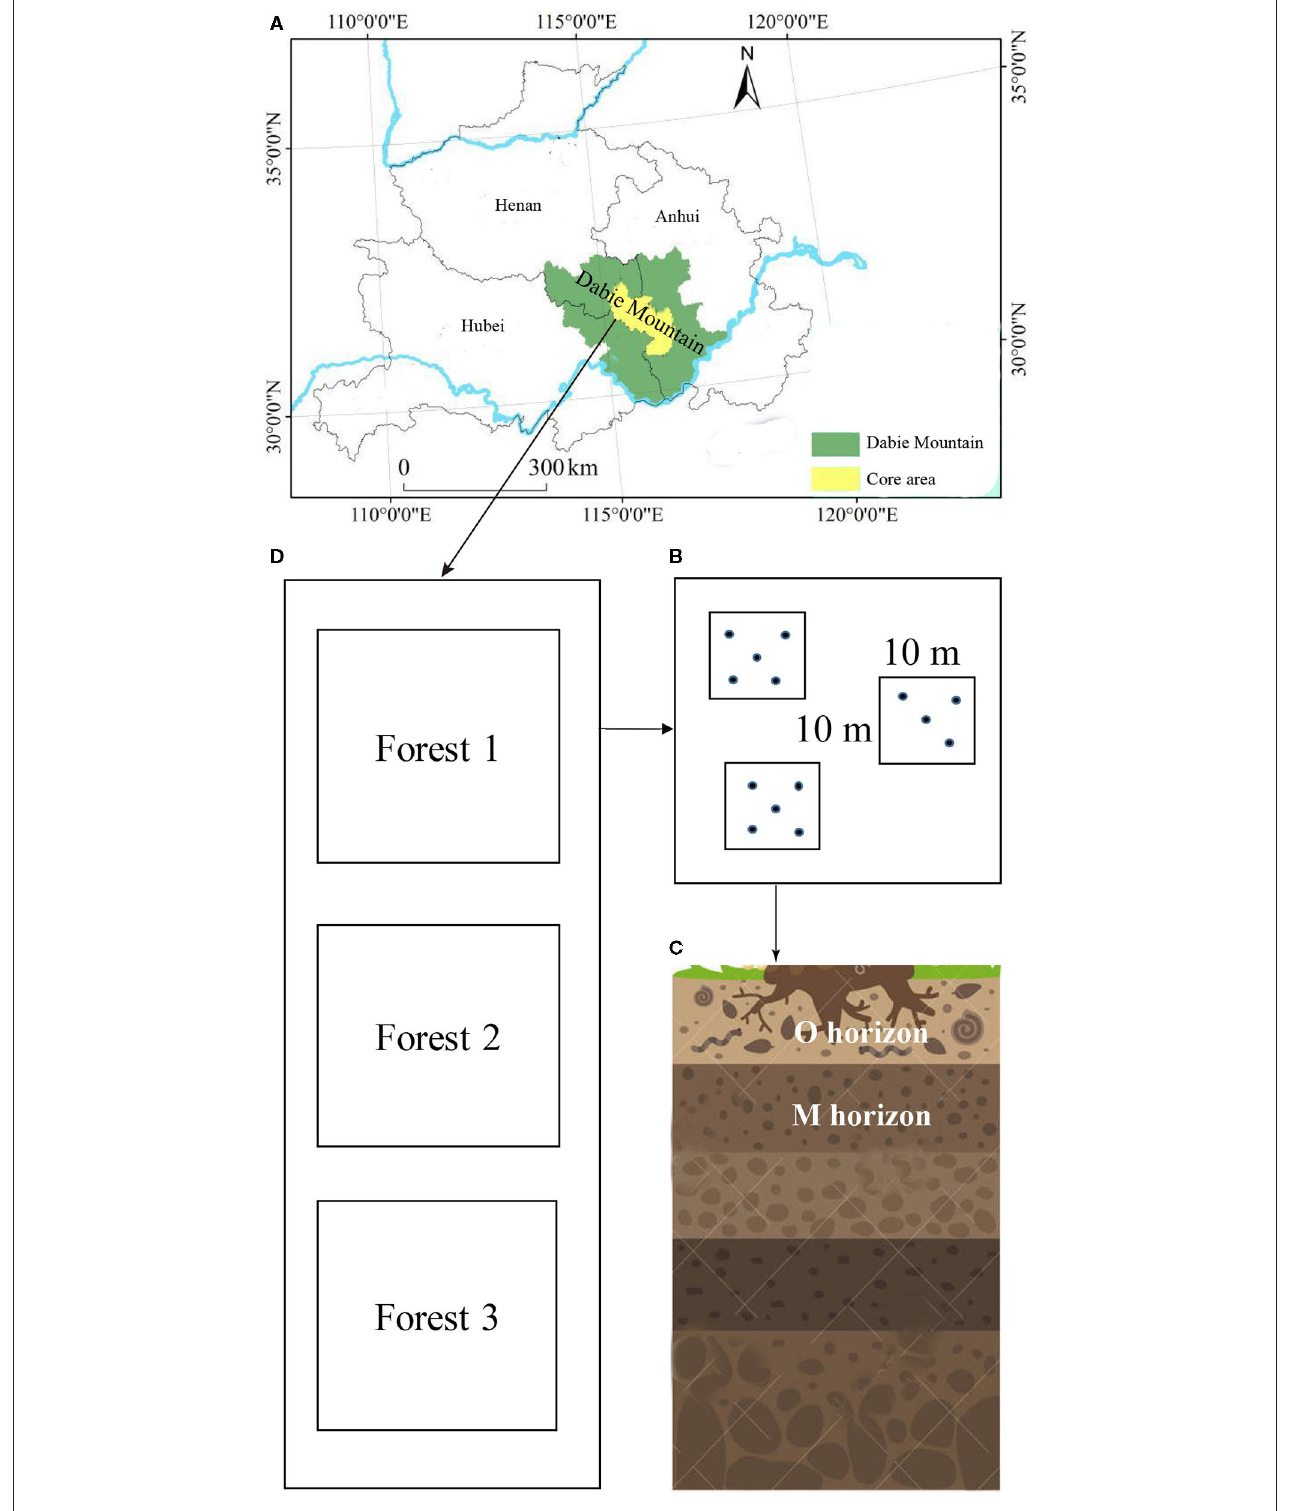
FIGURE 1 | Sampling locations within two sites of Dabie Mountain (A) in Anhui Province, China. Subsamples in three subplots (B) were collected from the O and M horizon (C) of three forest types (D) .